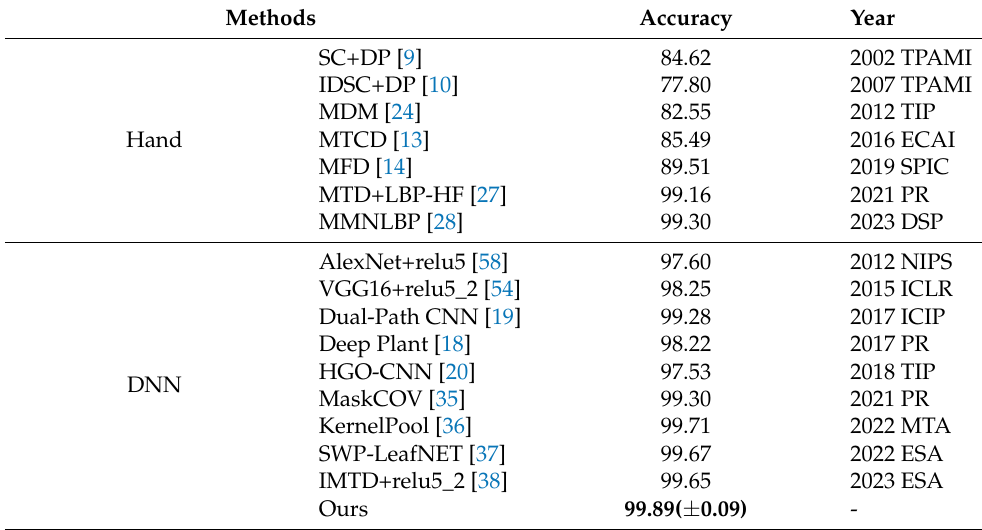
Table 4. Classification accuracy (%) comparison on Flavia dataset with identical settings.